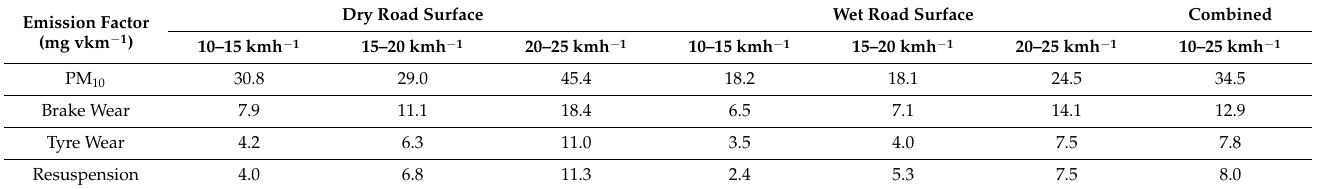
Table 4. Average fleet non-exhaust emission factors at Marylebone Road by speed and surface wetness (mg vkm − 1 ). Dry Road Surface Wet Road Surface Combined Emission Factor (mg vkm − 1 )